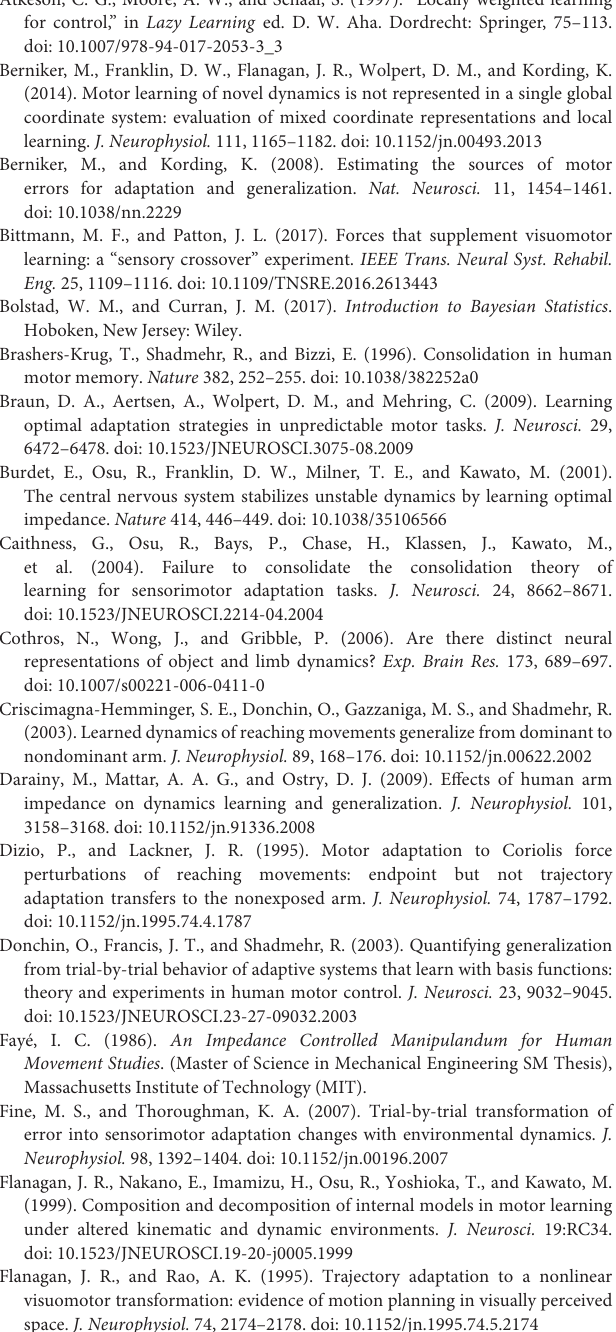
with EA{gain 1, offset 0}, and red curve is the fit of the affine mixed model (m.1.1). This richness of behavior, such as the oscillation about zero, is possible due to the multiple factors, a signed error metric, and iterative incremental learning considered in the model. Supplementary Figure 6 | Representative examples of movement paths from a subject practicing the learning task 3 with EA{gain 1,offset 1}. Green and red